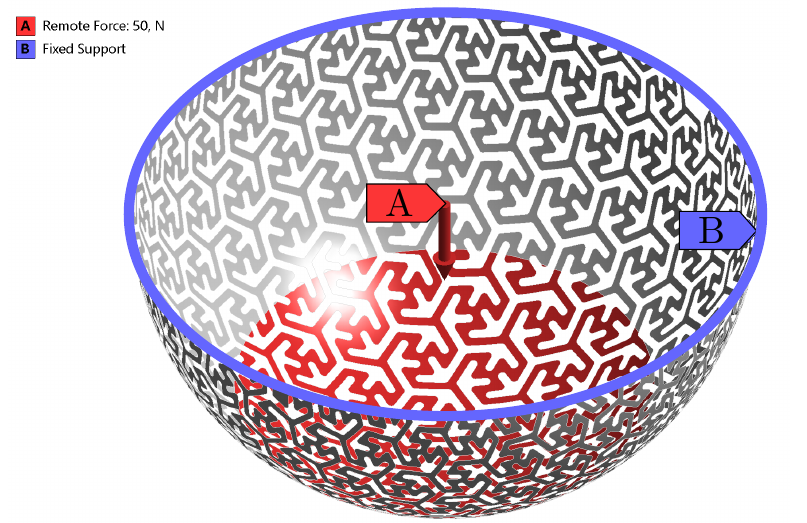
Figure 6. Boundary conditions for a simplified non-linear model analyses of structure